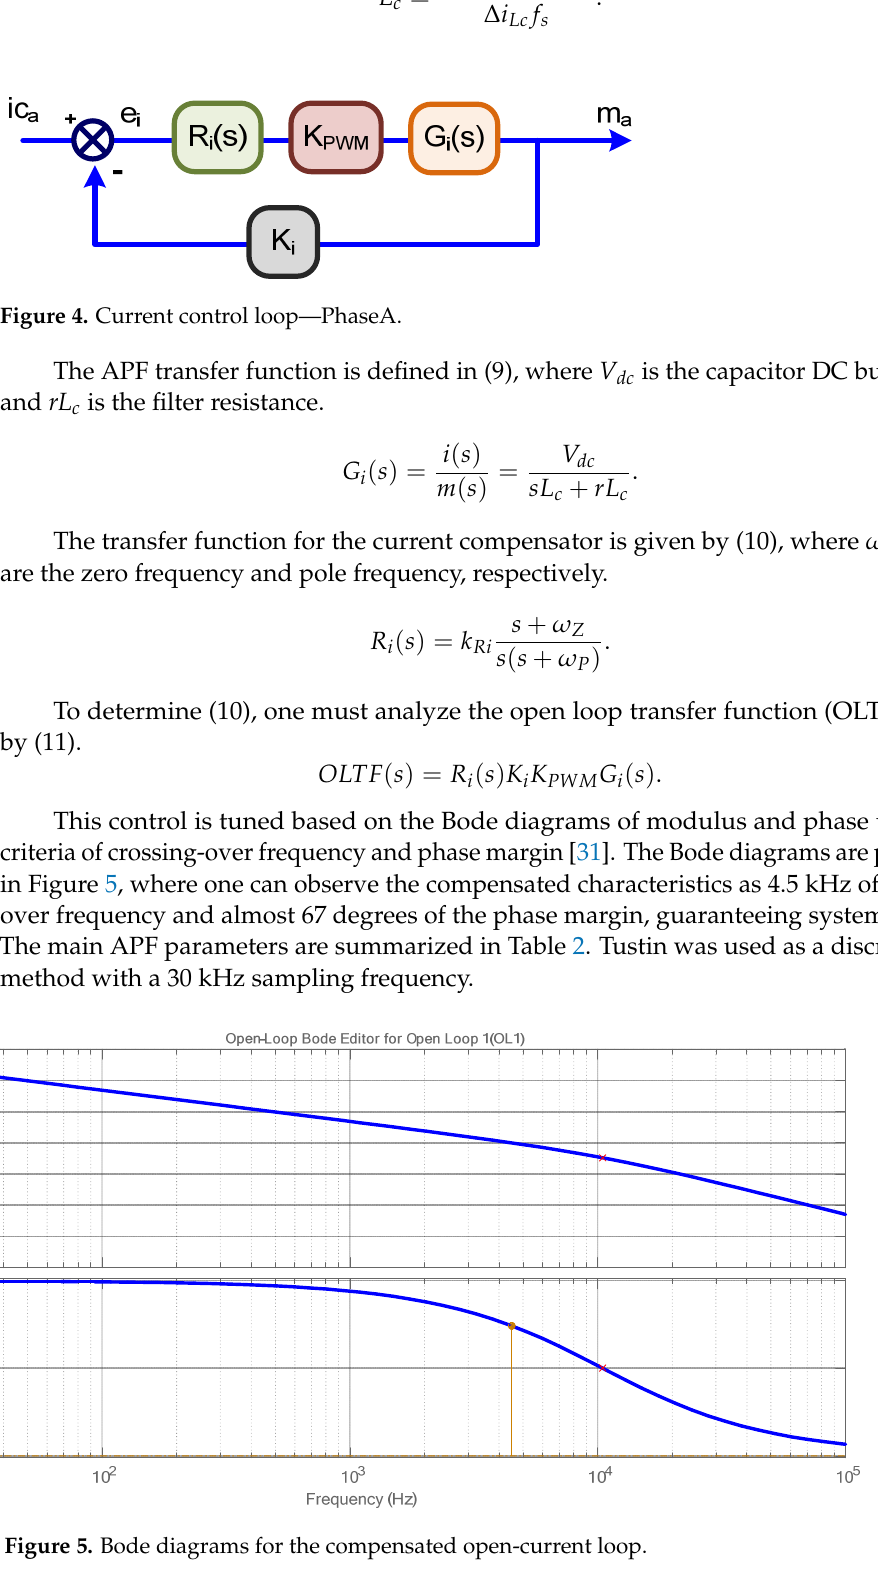
Figure 5. Bode diagrams for the compensated open-current loop.